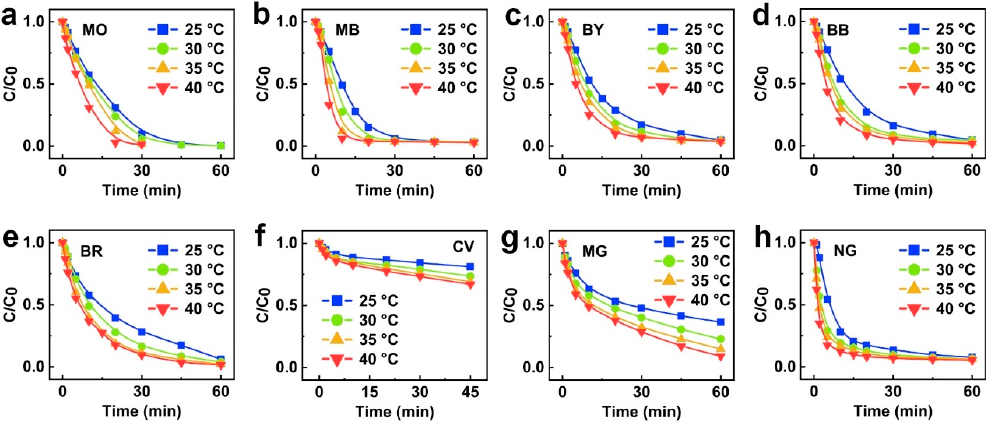
Figure 3. Decolorization of ( a ) MO, ( b ) MB, ( c ) BY, ( d ) BB, ( e ) BR, ( f ) CV, ( g ) MG and ( h ) NG by Fe 73.5 Si 13.5 B 9 Cu 1 Nb 3 metallic glass ribbons under 25–40 °C without UV-Vis irradiation (dye concentration: 20 ppm, catalyst dosage: 0.5 g/L, H 2 O 2 concentration: 1 mM, pH 3.0). Decolorization rates were measured from the λ max of the corresponding UV-Vis spectra with reaction time.